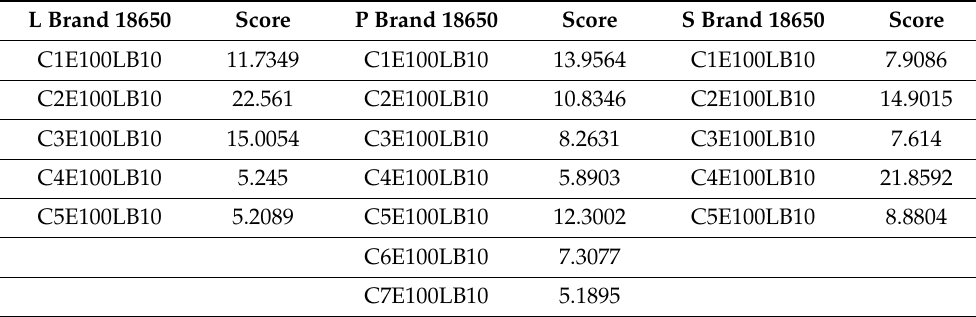
Table 5. Results of GRU, Epoch = 100, look_back = 10.